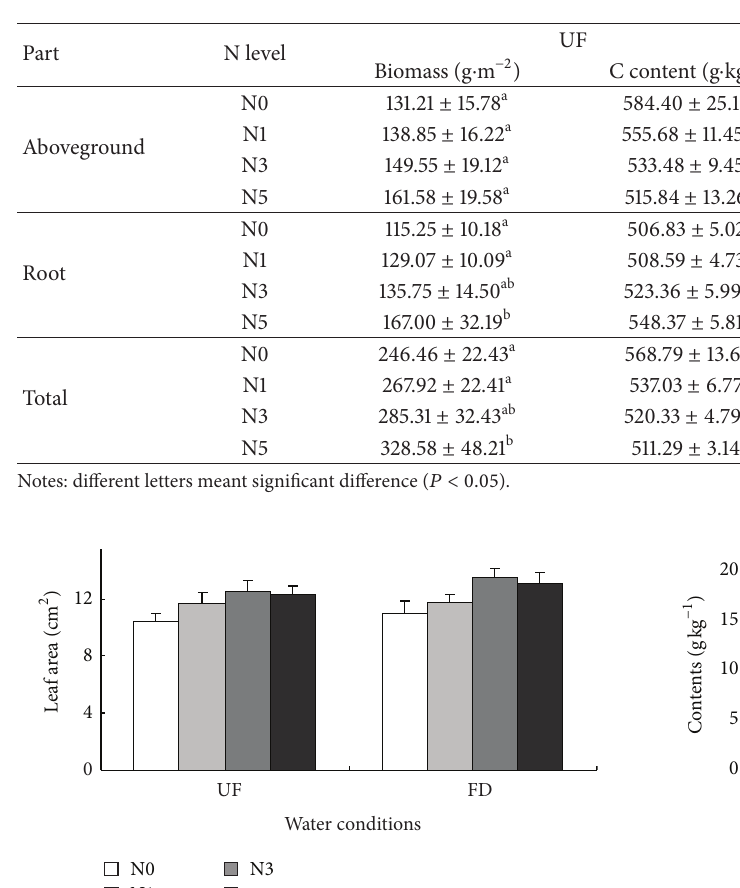
Table 1: The accumulation of biomass and carbon in C. angustifolia under N-deposition.